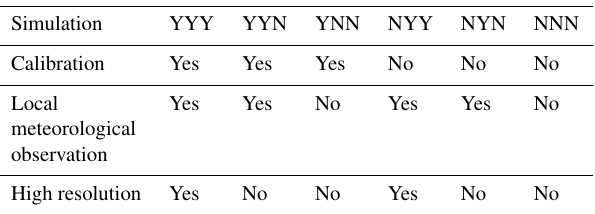
Table C1. Sensitivity simulation. The simulation names and the combinations of factors are given.